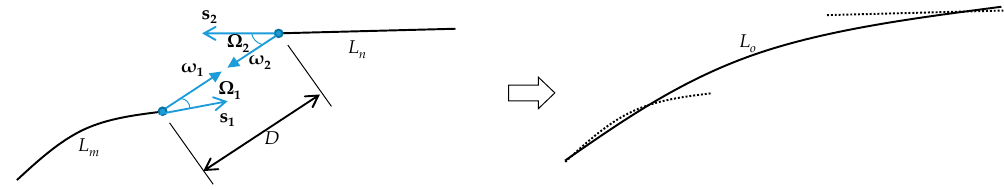
Figure 5. The sketch map of the proposed continuity optimization.